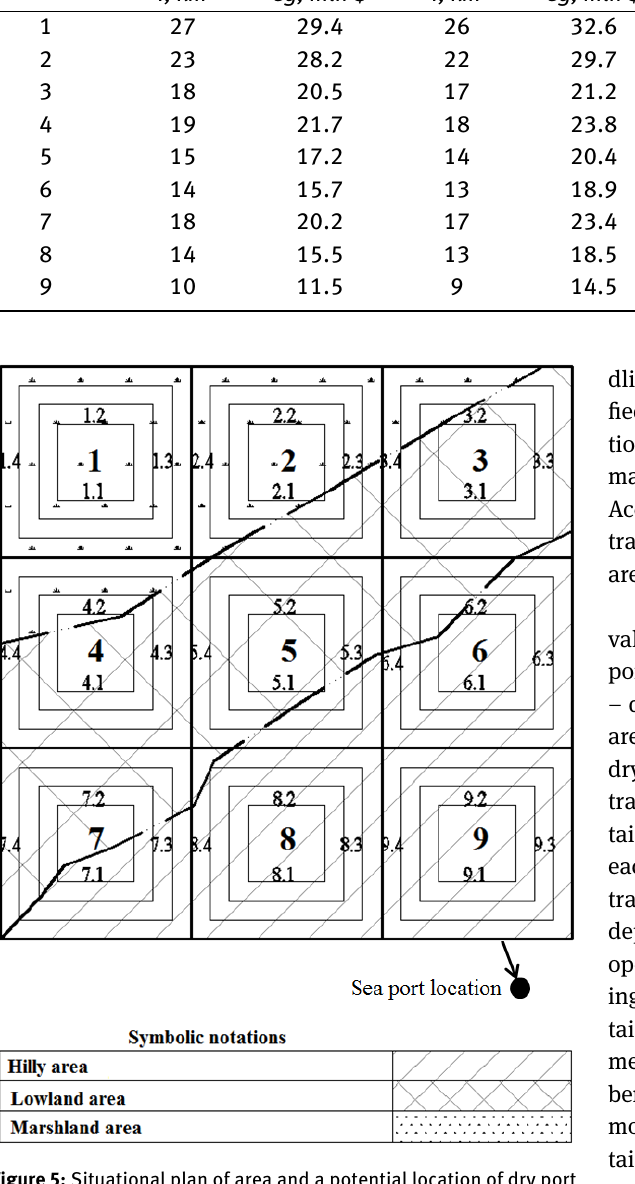
Figure 5: Situational plan of area and a potential location of dry port